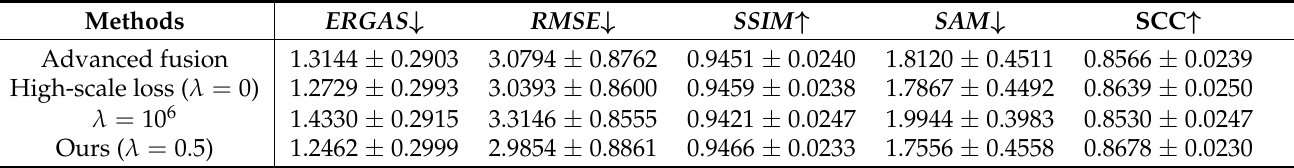
Figure 15. Qualitative results of the ablation study. From left to right: LRMS and PAN images, the results without applying preliminary and intermediate fusion networks (only applying the advanced fusion network), the results without using the low-scale loss (only using the high-scale loss, i.e., λ = 0), the results when λ = 10 6 , and the results of the proposed CPNet. Table 4. Quantitative results of the ablation